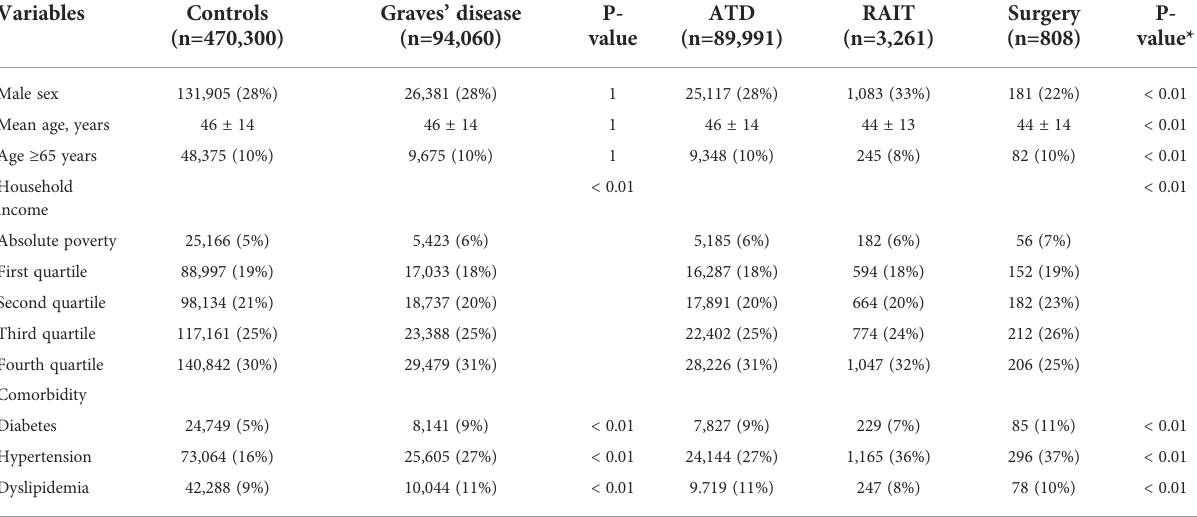
TABLE 1 Baseline characteristic of patients with Graves ’ disease and